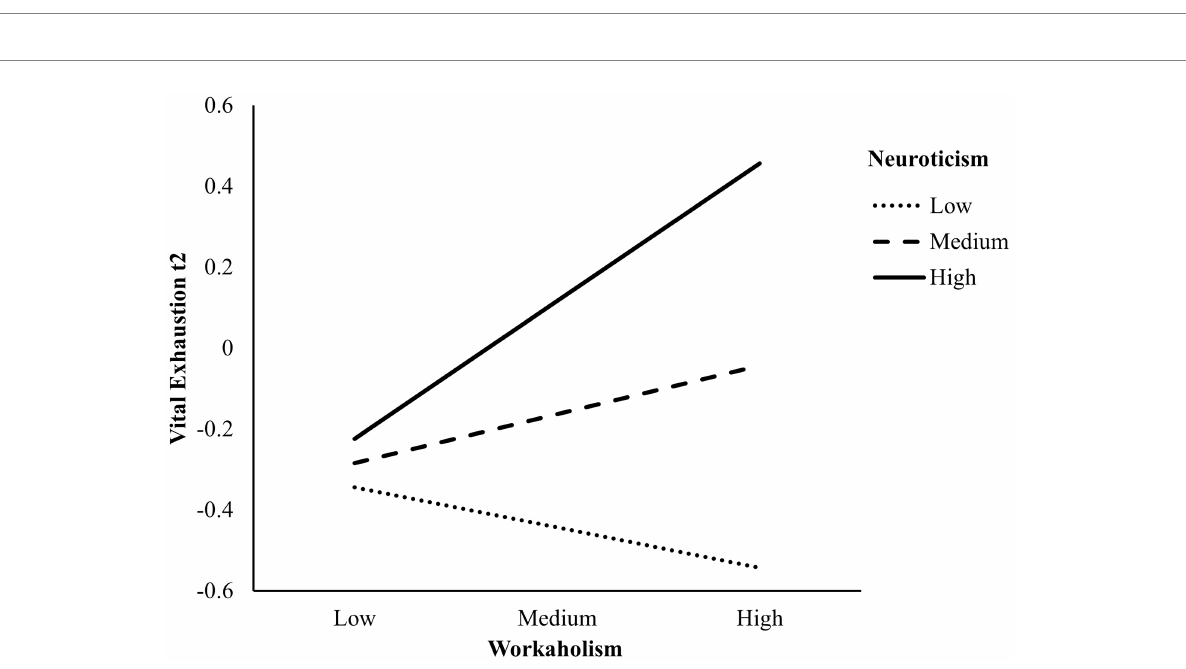
FIGURE 2 Interaction between workaholism x neuroticism on vital exhaustion at t2, controlling for vital exhaustion at t1 and sex ( N =